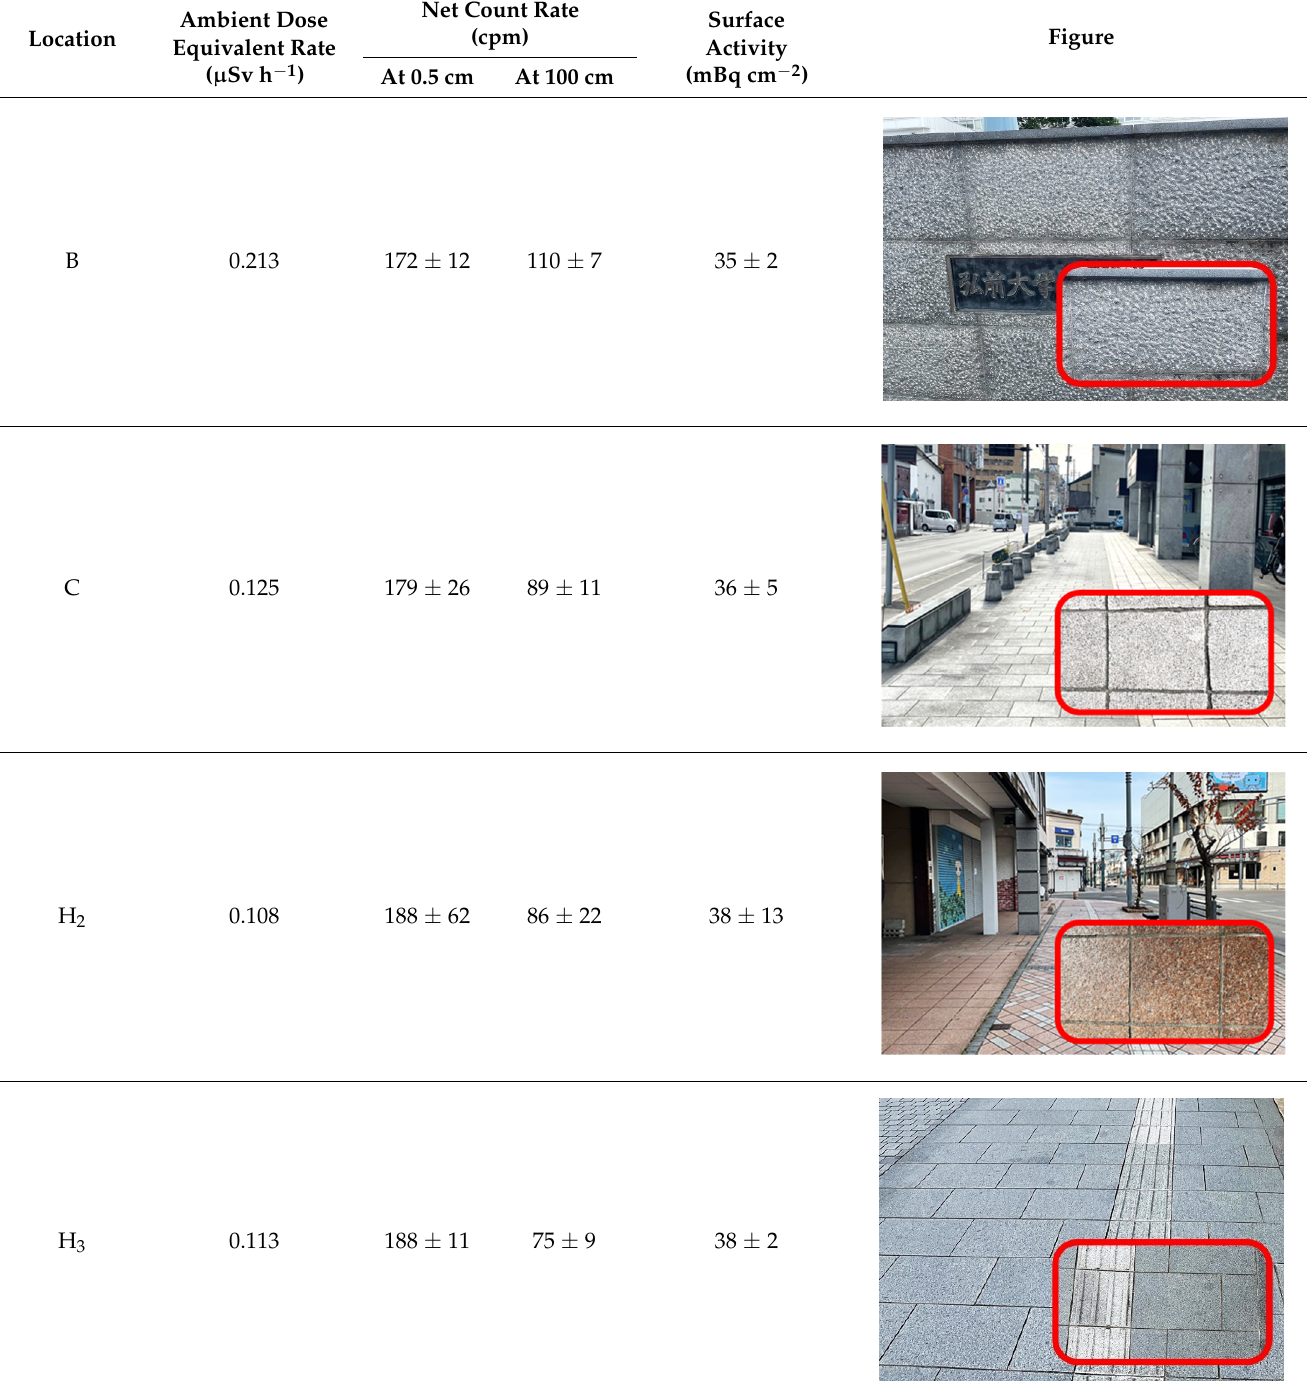
Figure 8. Gamma-ray pulse-height distributions measured at hotspot locations obtained from spot measurements. 3.5. Comparison of Dose Rate Distribution Maps between Walking Survey and Spot Measurements The walking survey and the spot measurements were performed together on the Bunkyo campus, Hirosaki University, under the established conditions. Figure 9a shows the dose rate distribution map obtained from the spot measurements at 52 points during a total measurement time of about 8 h. The ambient dose equivalent rate was in the range 0.038–0.068 µSv h − 1 with an average value of 0.052 ± 0.008 µSv h − 1 and was highest